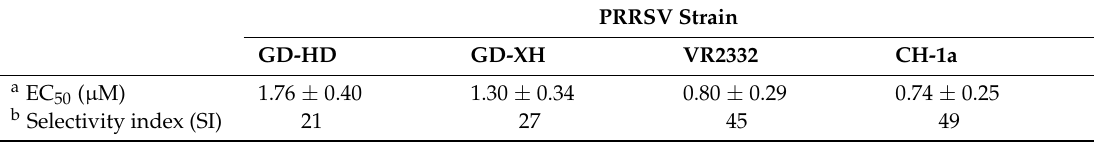
Table 2. Inhibitory activity of platycodin D (PD) against PRRSV infection in MARC-145 cells.